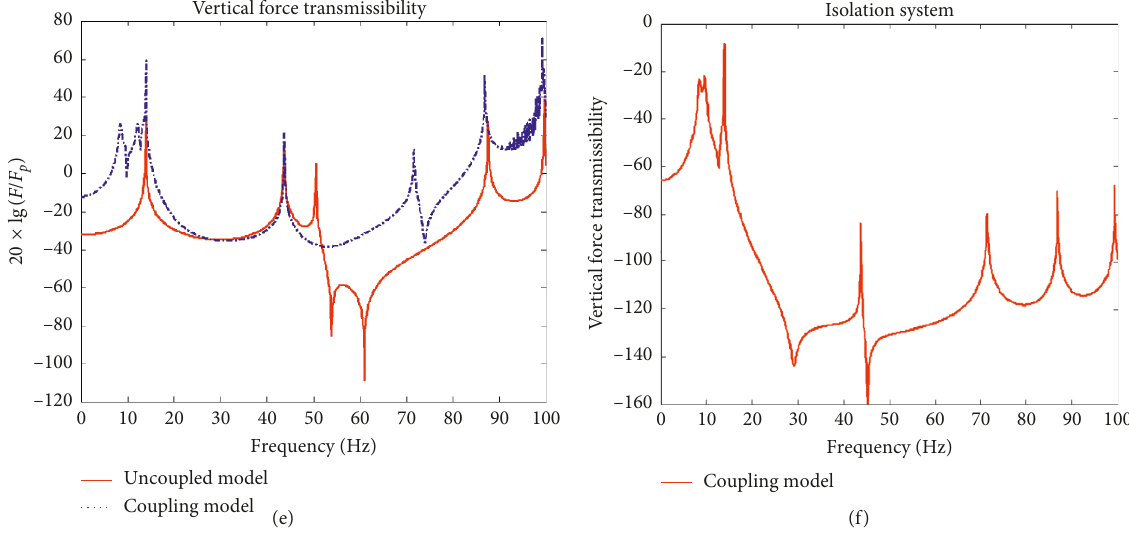
Figure 17: Vertical force transmissibility on every path. (a) 1#. (b) 2#. (c) 3#. (d) 4#. (e) 5#. (f) Isolation